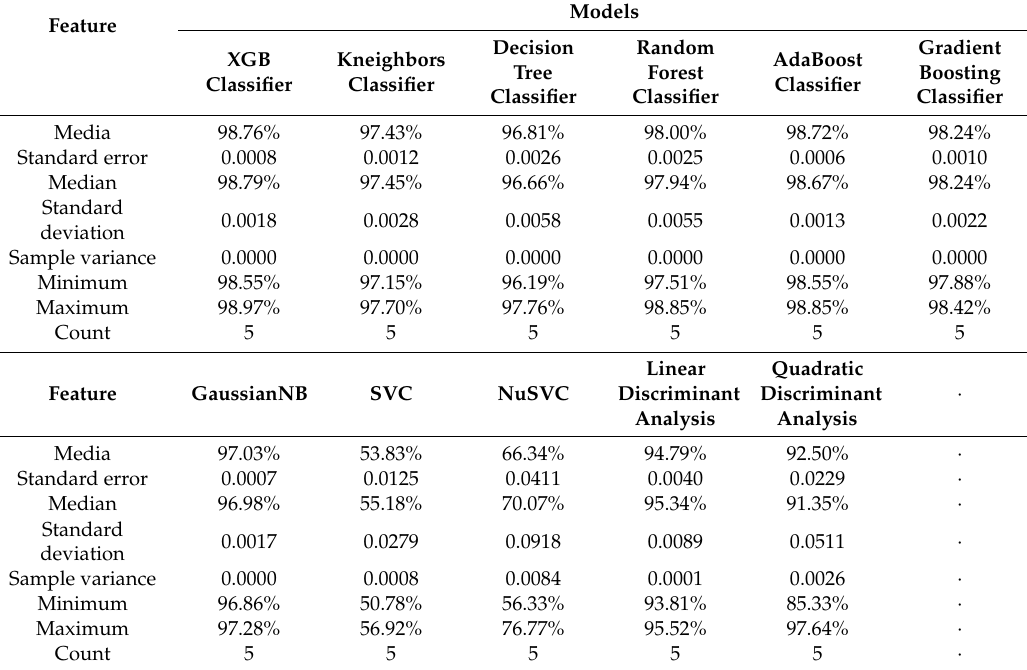
Table 6. Statistical results extracted from